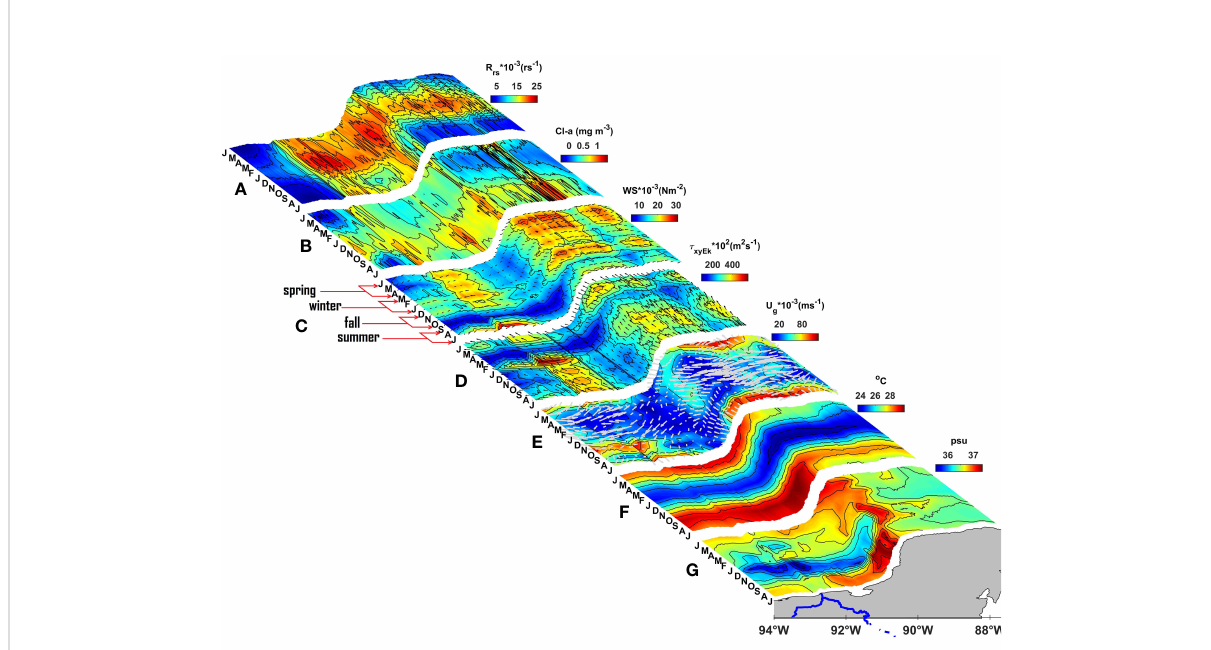
FIGURE 6 Hovmöller diagram of (A) Turbidity, (B) Chlorophyll, (C) Wind Effort, (D) Meridional Ekman Transport, (E) Geostrophic Velocity, (F) Sea Surface Temperature and (G) Modeled